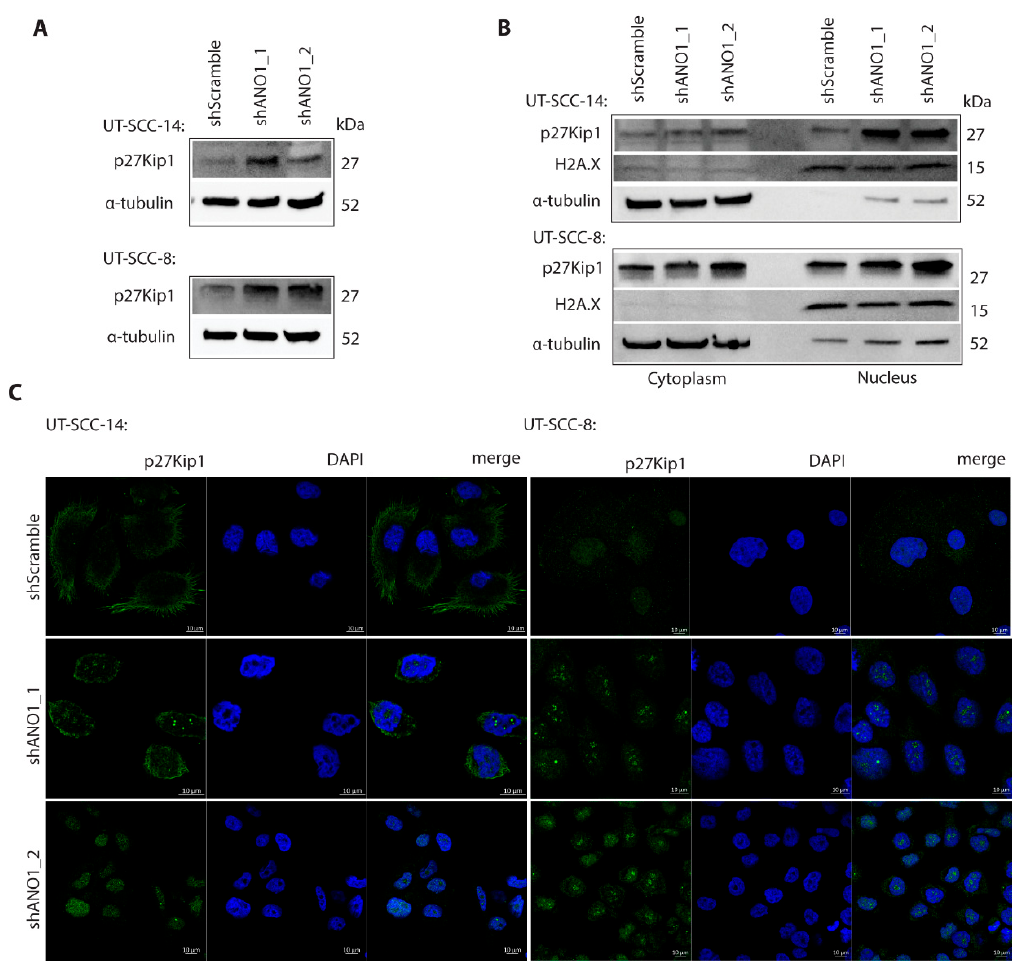
Figure 4. ANO1 modulates localization of p27 Kip1 and expression of these genes is inversely correlated. ( A ) Expression of p27 Kip1 in UT-SCC-14 and UT-SCC-8 shScramble and shANO1 cell lines, respectively, by immunoblotting. Alpha-tubulin is the loading control. ( B ) Western blot analysis depicting the distribution of p27 Kip1 expression following fractionation of nuclear and cytoplasmic lysate extracts. H2A.x is the marker of nuclear fraction and α -tubulin marker of the cytoplasmic fraction in UT-SCC-14 and UT-SCC-8 shScramble and shANO1 cell lines. ( C ) Representative immunofluorescent confocal microscopy images depict the differential intensity and subcellular localization of p27 Kip1 in UT-SCC-14 and UT-SCC-8 shScramble and shANO1 cell lines, respectively. Scale bars included in the right corner of each image indicate the respective size.